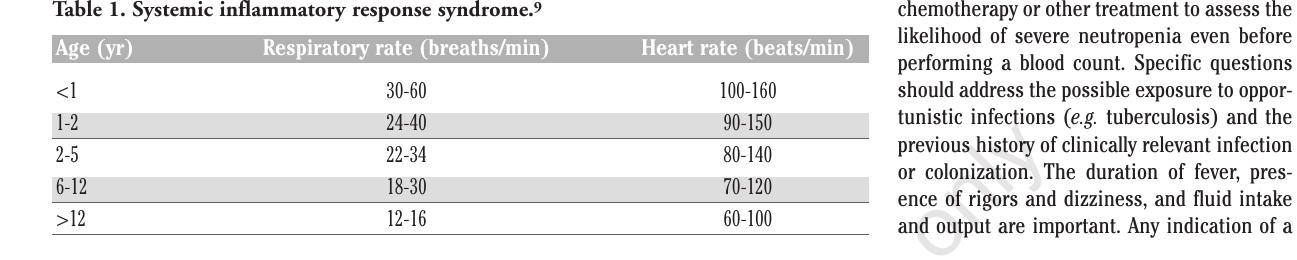
Table 1. Systemic inflammatory response syndrome.